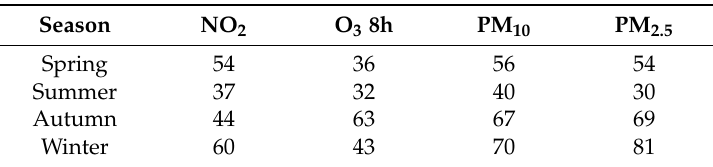
Table 2. Seasonal average concentrations for air pollutants in Shenzhen from March 2013 to February 2014 (mg/m 3 for CO, μ g/m 3 for others).